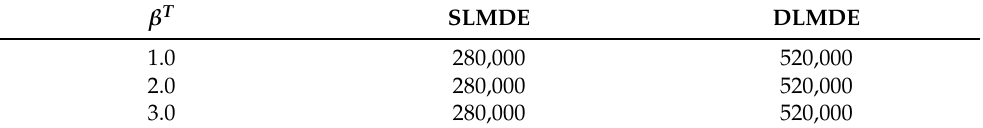
Table 10. Number of function evaluations required by both methods for Example 4. β T